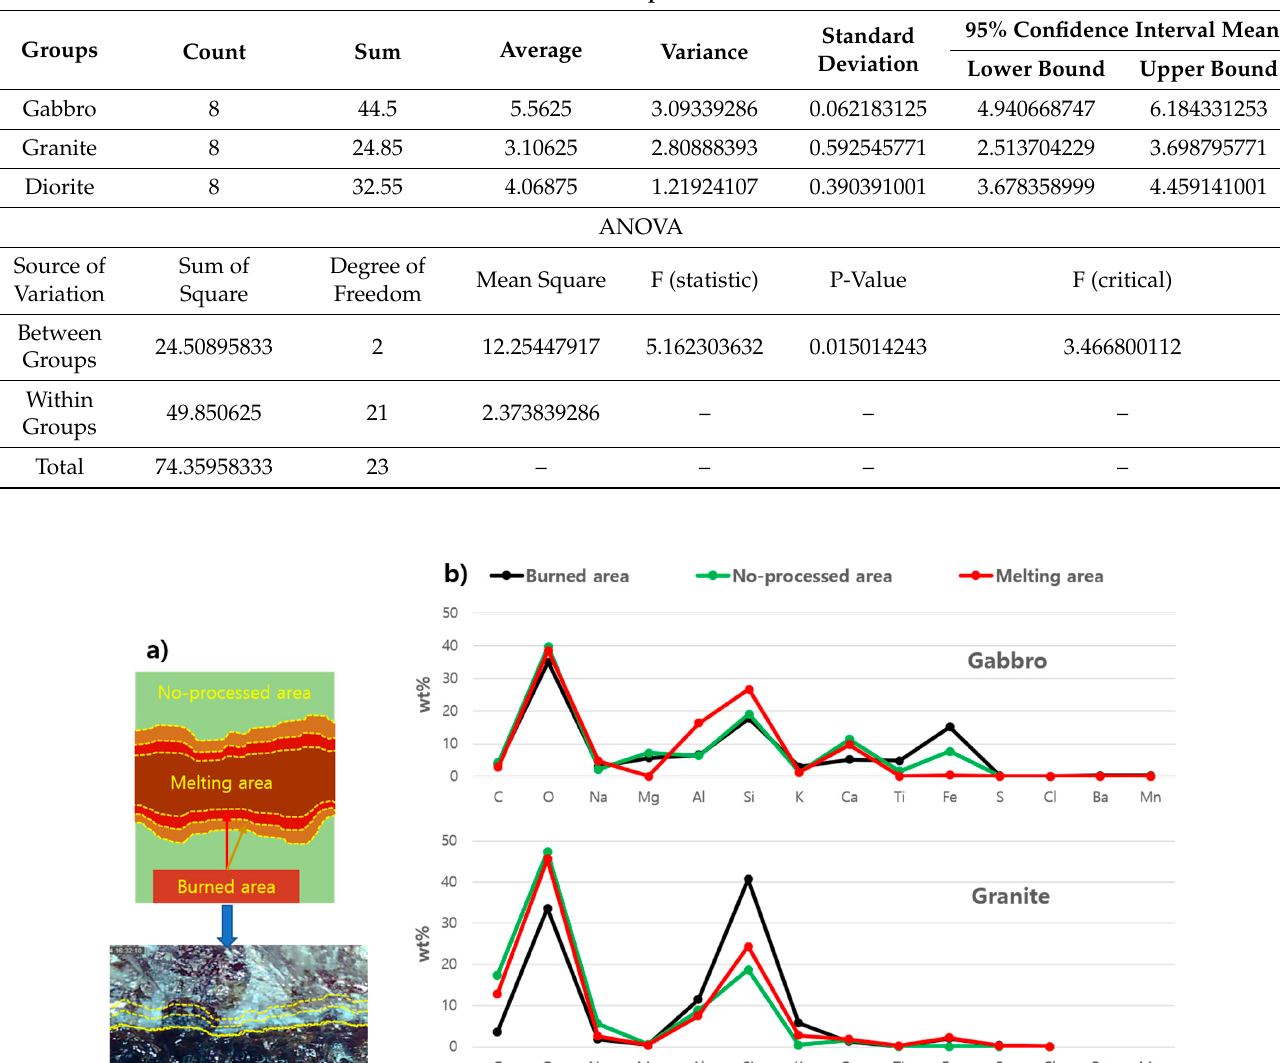
Table 4. Statistical analyses for the penetration depths of each rock specimen related to different scanning speeds. Descriptive